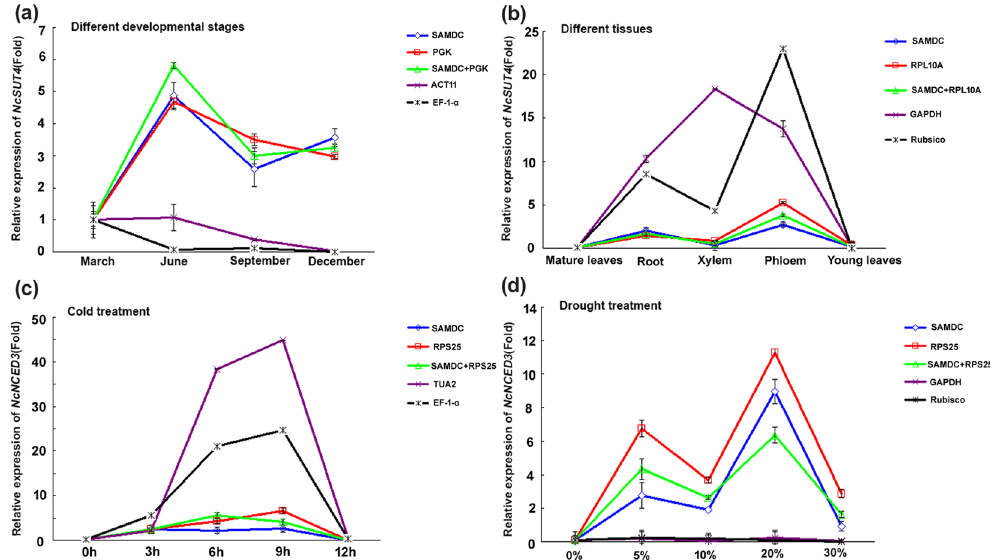
Figure 5. Relative quantification of NcSUT4 and NcNCED3 expression levels using the most and least stable reference genes for normalization in the given experimental conditions. ( a ) Expression level of NcSUT4 at different developmental stages. Most stable reference genes ( SAMDC , PGK ) and least stable reference genes ( ACT11 , EF-1- α ) were used, respectively; ( b ) expression level of NcSUT4 in different tissues. Most stable reference genes ( SAMDC , RPL10A ) and least stable reference genes ( GAPDH , Rubisco ) were used, respectively; ( c ) expression level of NcNCED3 under cold treatment. Most stable reference genes ( SAMDC , RPS25 ) and least stable reference genes ( TUA2 , EF-1- α ) were used, respectively; ( d ) expression level of NcNCED3 under drought treatment. Most stable reference genes ( SAMDC , RPS25 ) and least stable reference genes ( GAPDH , Rubisco ) recommended by BestKeeper were used, respectively. The error bars represent the mean of three biological replicates ±